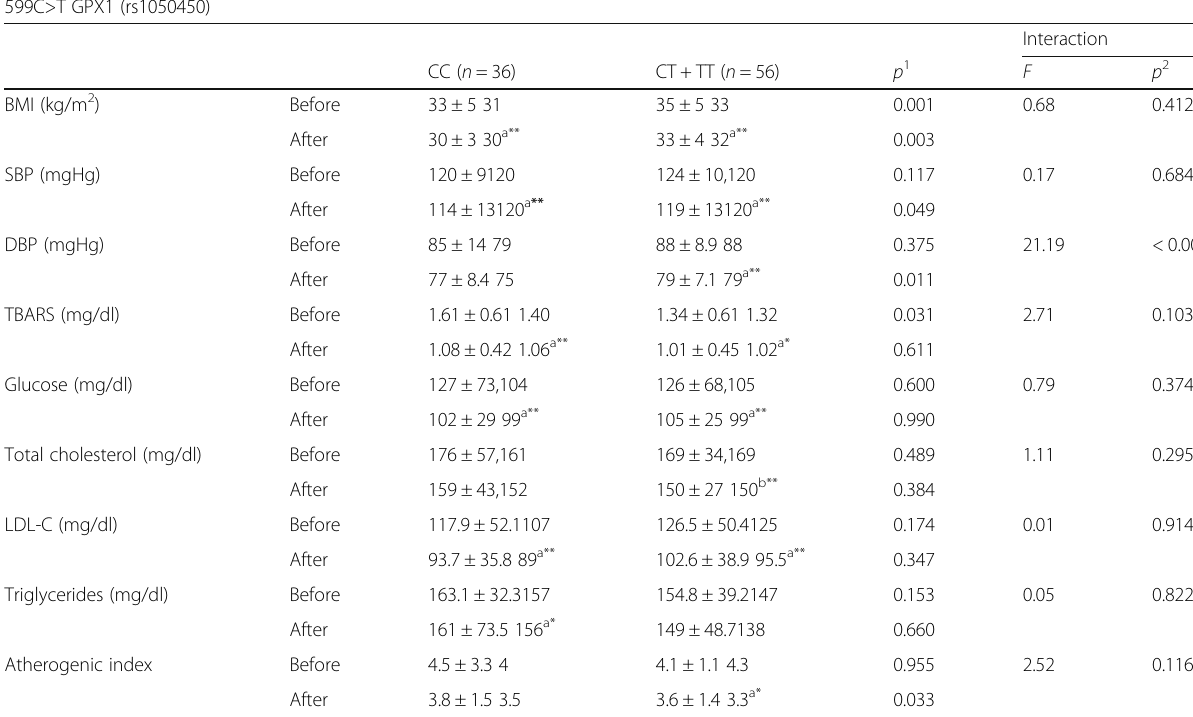
Table 2 Effect of the dietary intervention on participants stratified by 599 C>T GPX1 (rs1050450) polymorphisms and interaction between period and group 599C>T GPX1